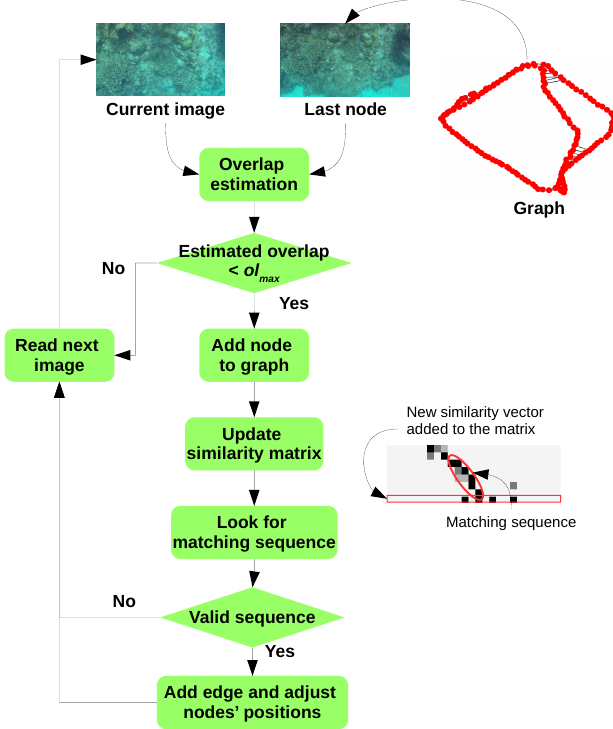
Figure 1. General overview of the proposed